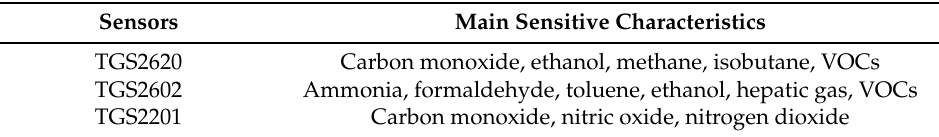
Table 1. Main sensitive characteristics of gas